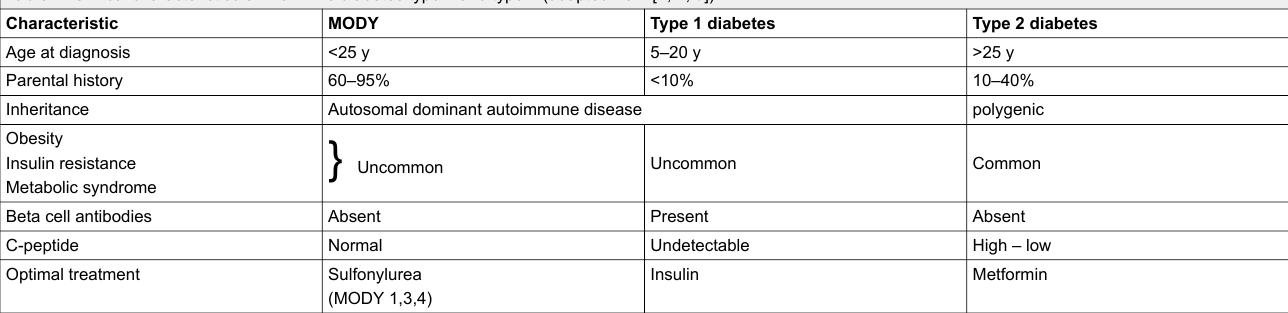
Table 1: Clinical characteristics of MODY vs diabetes type 1 and type 2 (adapted from [1, 2, 9]). Characteristic